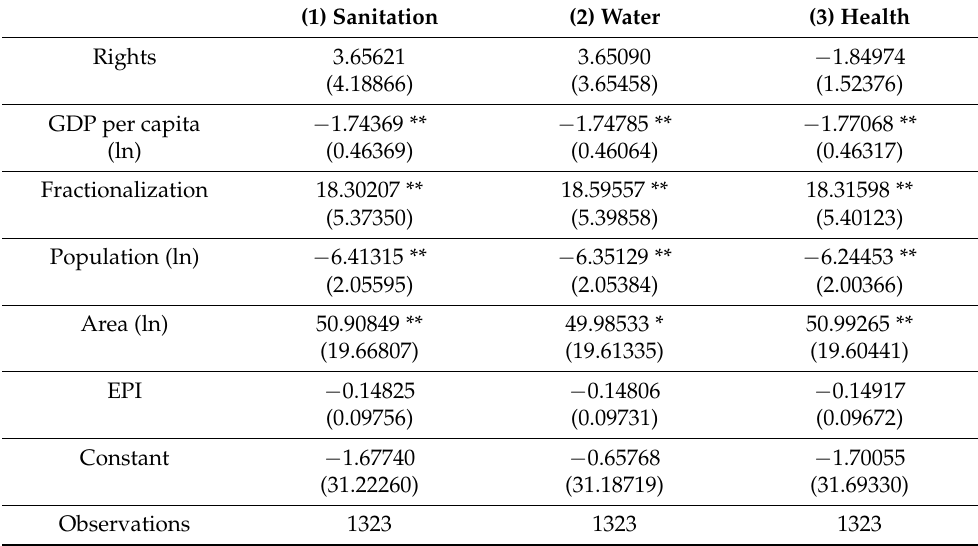
Table 4. Rights & Open Defecation,